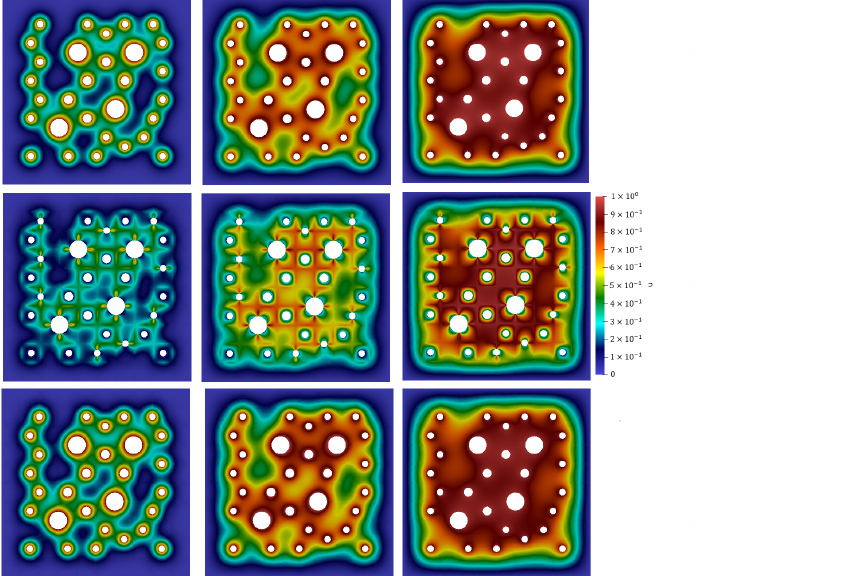
Figure A2. Parabolic problem with α = 100 for different time layers t m with m = 5,15, and 40 (from left to right ). Case 2 (non-homogeneous boundary conditions). Top : Reference solution ( DOF h = 85,230). Center : Multiscale solution with 12 multiscale basis functions without perforation basis functions, e L 2 = 46.53 for t 5 , e L 2 = 35.14 for t 15 , and e L 2 = 22.84 for t 40 ( M g = 12, M p = 0, DOF H = 1300). Bottom : Multiscale solution with 12 multiscale basis functions with perforation basis functions, e L 2 = 2.506 for t 5 , e L 2 = 1.621 for t 15 , and e L 2 = 0.742 for t 40 ( M g = M p = M = 12, DOF H = 1776).